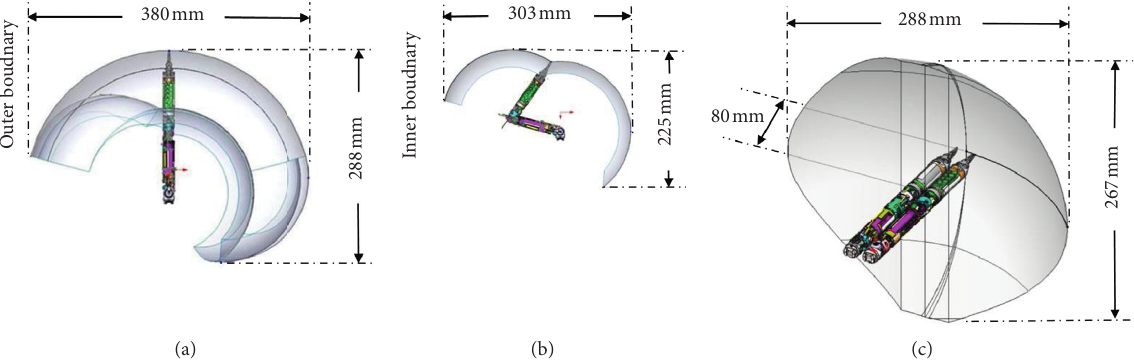
Figure 4: Robotic arm (a) outer workspace limits, (b) inner workspace limit, and (c) shared workspace.